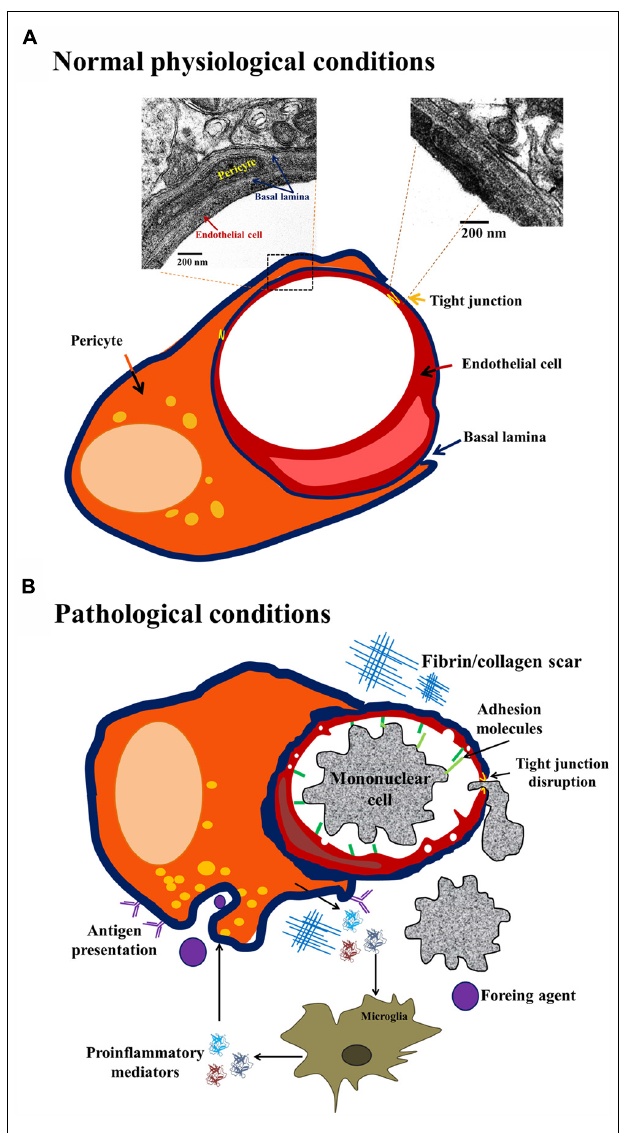
FIGURE 1 | Brain pericyte phenotype in normal and pathological conditions. Under normal physiological conditions (A) brain pericytes exhibit tight junctions (Tjs) with endothelial cells (ECs), and are embedded in the basal lamina. Under pathological conditions, such as injury, infection or neurodegeneration (B) , pericytes present a migrating phenotype with up-regulation of ICAM expression, pro-inflammatory cytokine release with ensuing recruitment of peripheral mononuclear cells. Additionally, under pathological conditions, the continuity of basal lamina is lost and the existence of fibrin scars contributes to blood–brain barrier